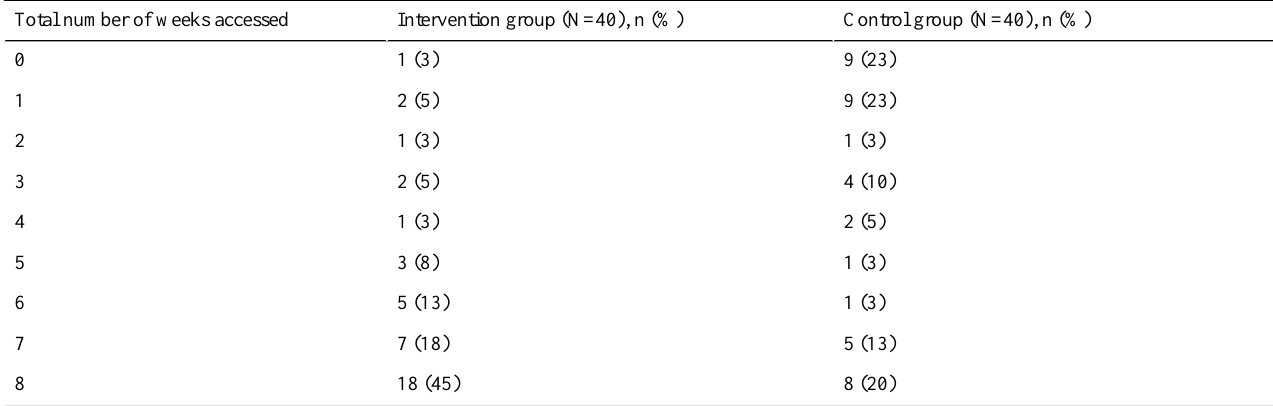
Table 4. Participant